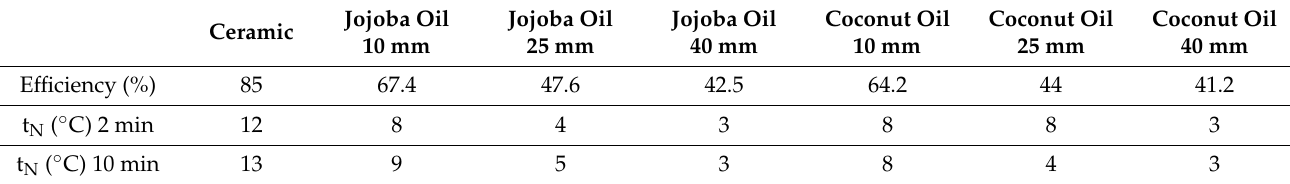
Table 4. Efficiency of heat recovery and temperature of the supply air.